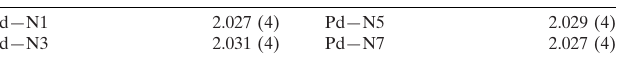
Selected bond lengths (A˚ ).